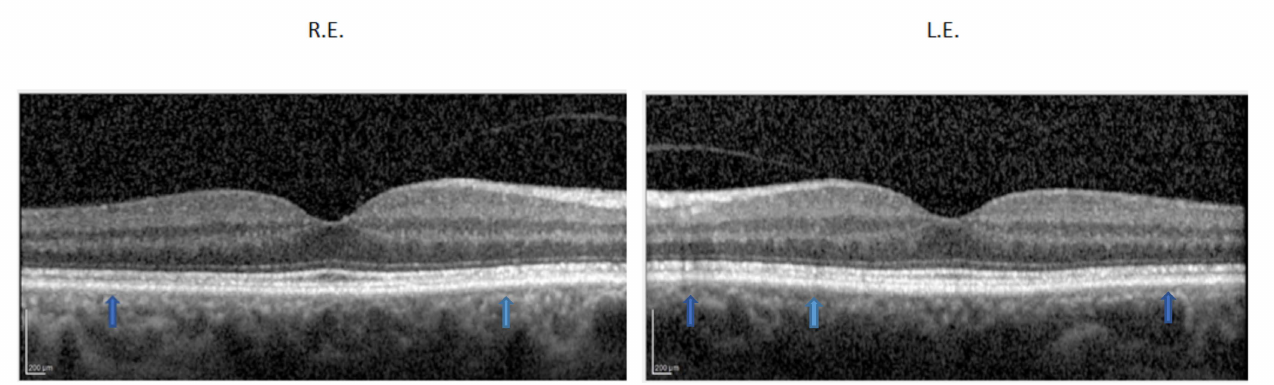
Figure 4. SD-OCT macular scan of the carrier showing a preserved foveal morphology with mild diffuse irregularity of the ellipsoid and retinal pigmented epithelium layers (arrows) in both eyes.